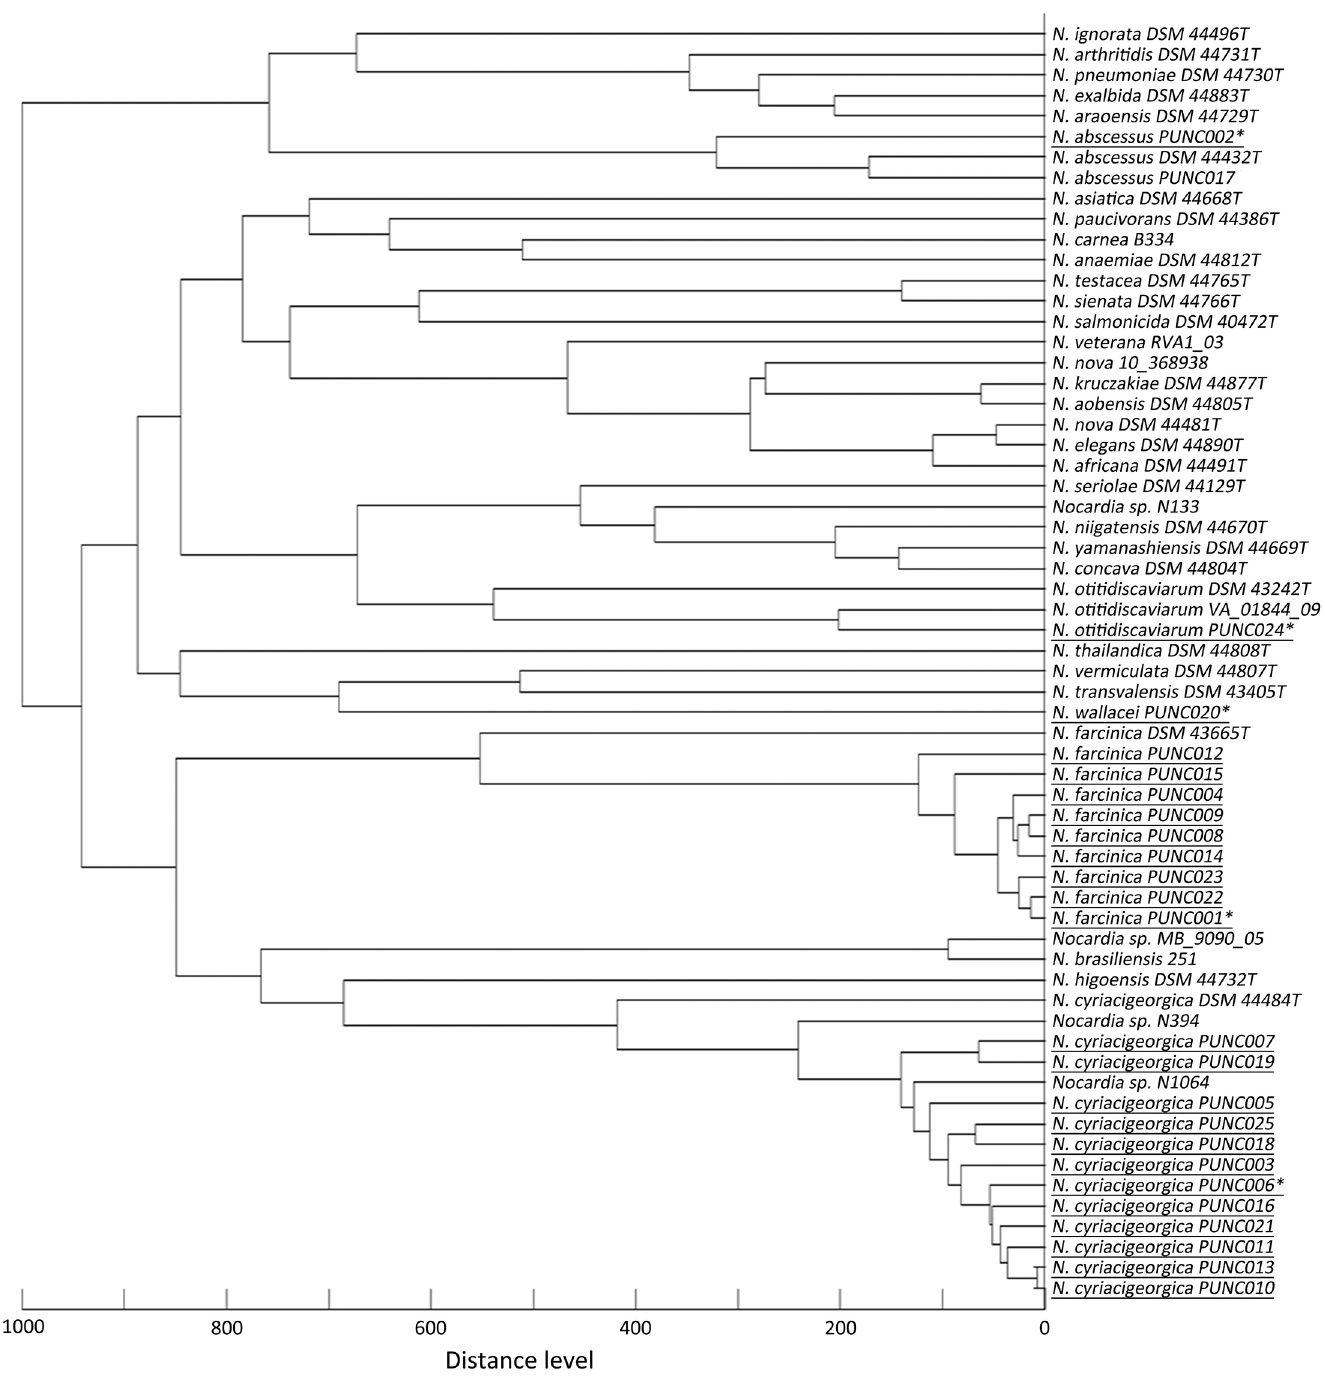
Fig 2. The main spectrum profile (MSP) dendrogram constructed using spectra of 25 Nocardia clinical strains along with 37 reference spectra of 32 Nocardia species contained in the original Biotyper database (version 3.1; Bruker). Strain identification numbers of clinical isolates collected in the present study are shown underlined, and isolates used for establishment of the “ in-house ” database was labeled with